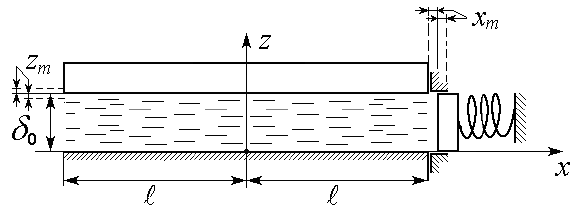
Figure 1. Scheme of a two-dimensional channel with an endwall supported by a spring.